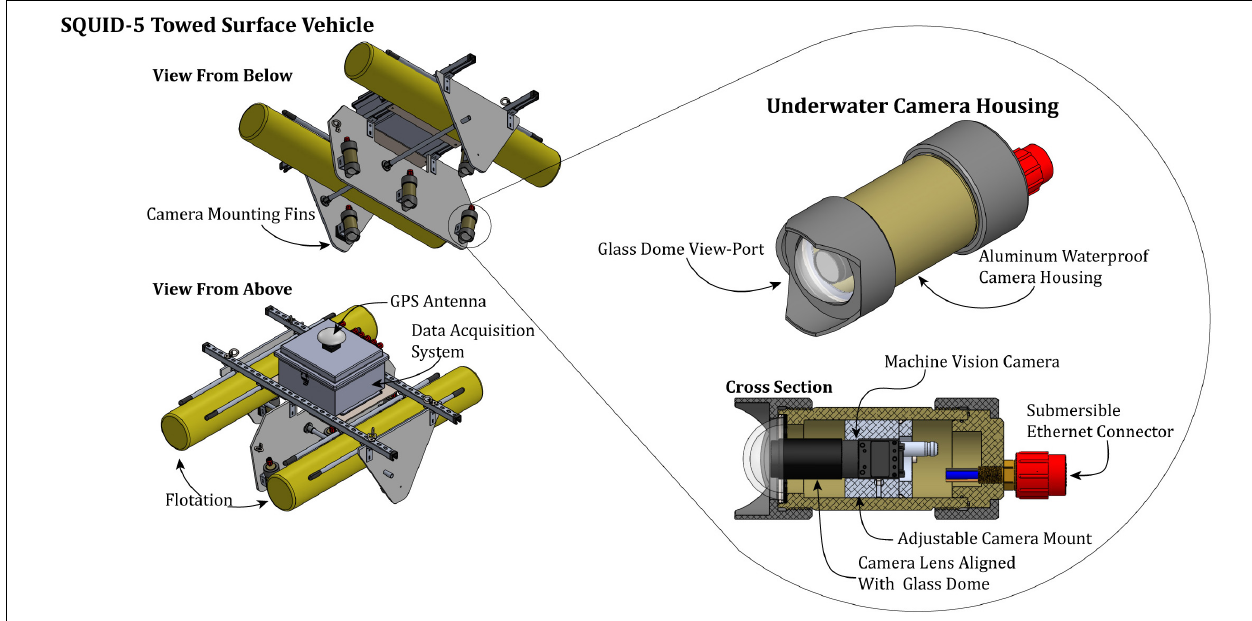
FIGURE 2 | Diagram of the SQUID-5 towed surface vehicle and the waterproof camera housings with labeled components. The camera mounting mechanism aligns the camera axially with the dome and allows the camera to be adjusted fore and aft to accommodate various lens types and enable alignment with the glass port radius of curvature for minimal